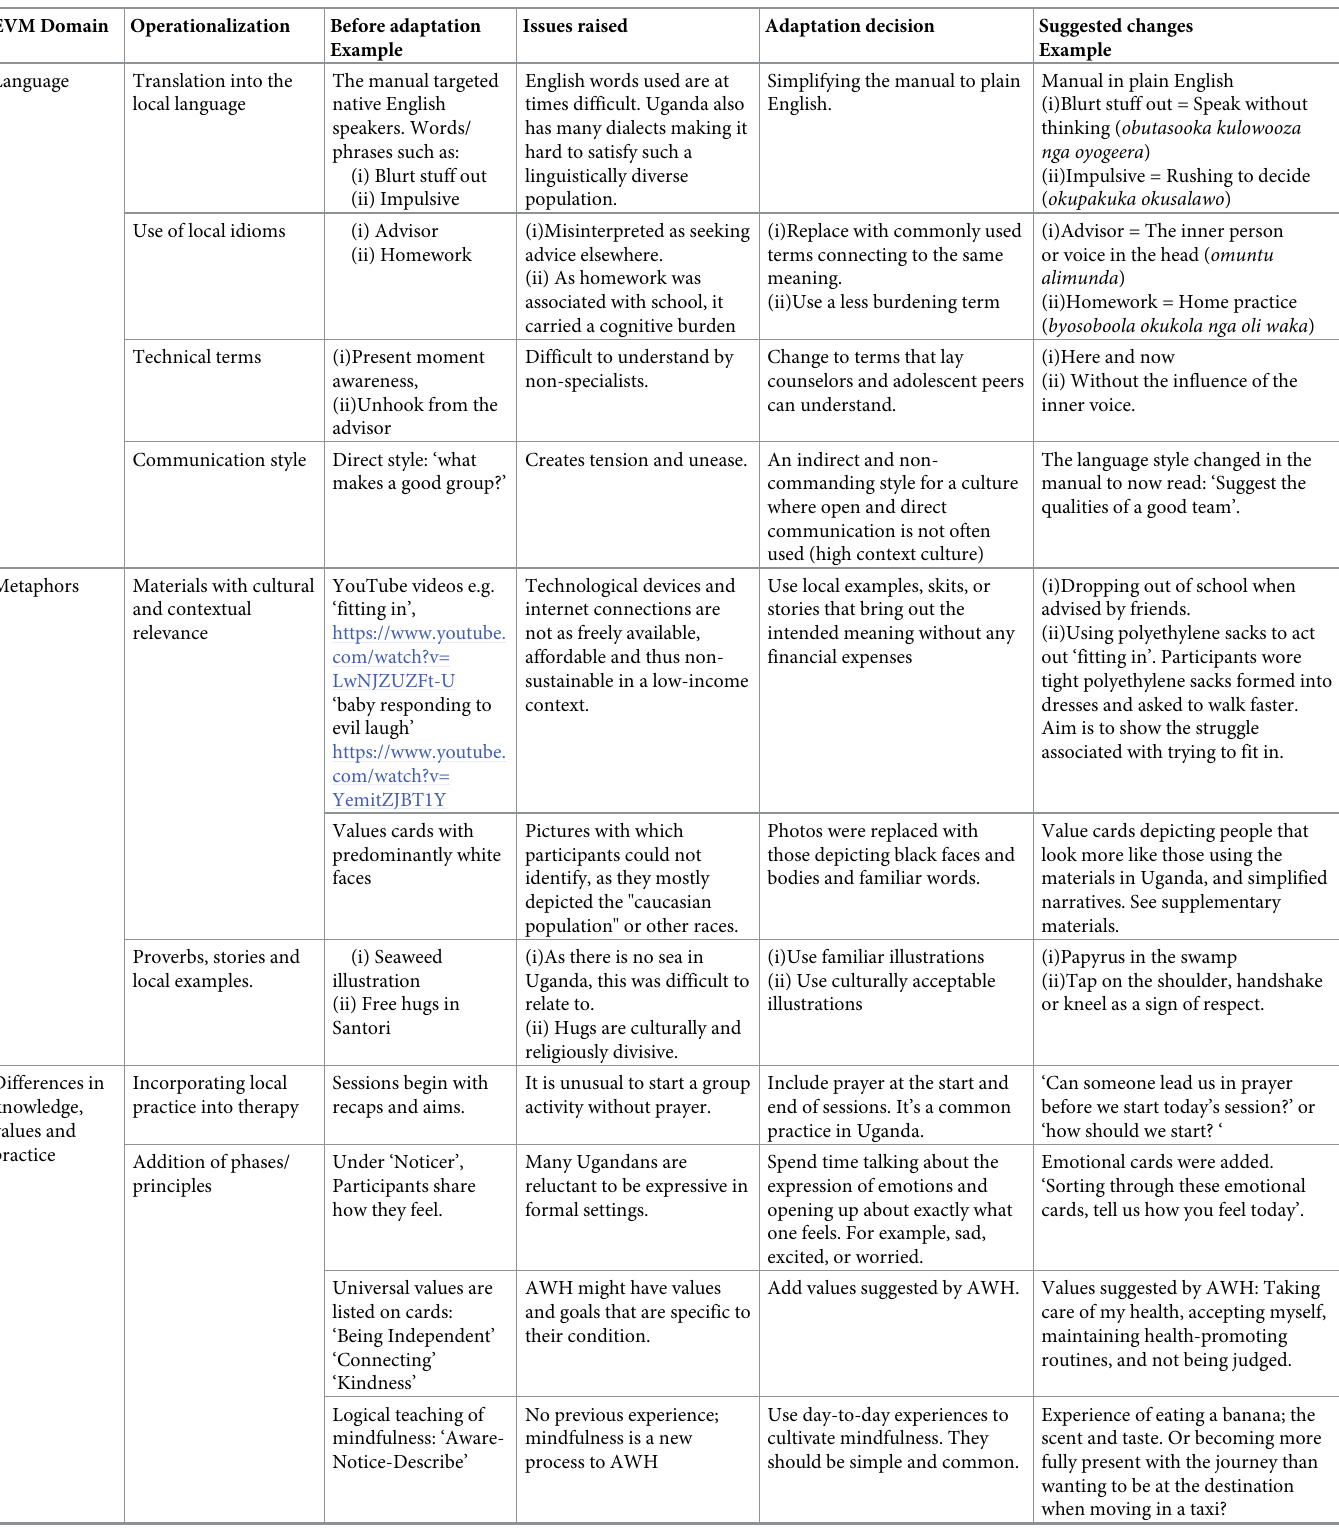
Table 1. Key adaptations to group DNA-v therapy using the ecological validity